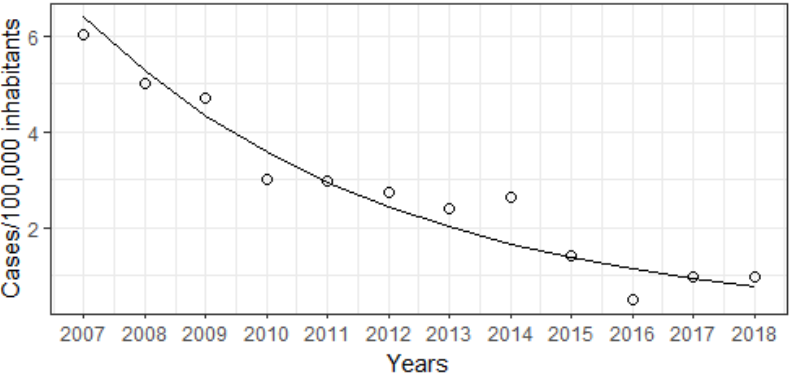
Figure 3. Hepatitis A observed (points) and modeled (line) occurrence in Brazil from 2007 to 2018.